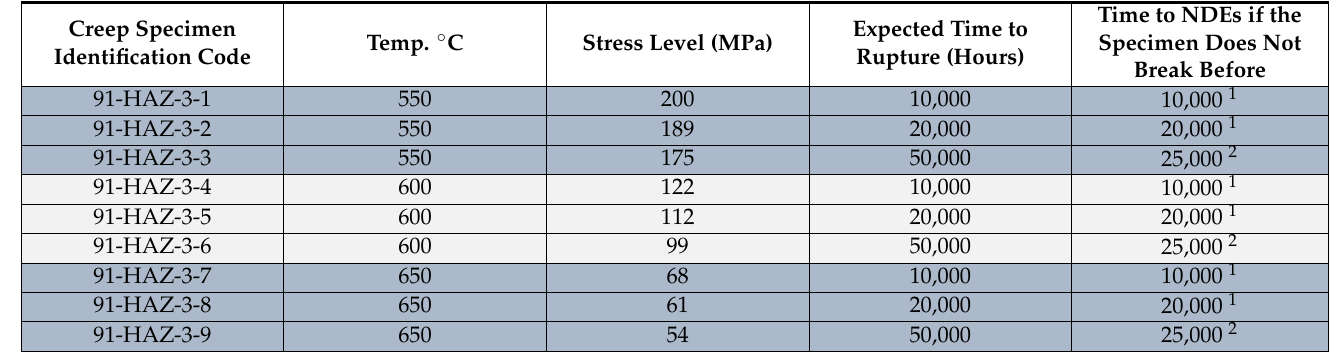
Table 5. Creep test program of subproject N ◦ 3: 3 GR 91 HAZ creep (with a background gray level for each temperature group, which is 550 ◦ C, 600 ◦ C and 650 ◦ C). The last column is the schedule for the other tests to be performed on the creep specimen (after the specimen rupture or after the number of hours indicated in the last column).